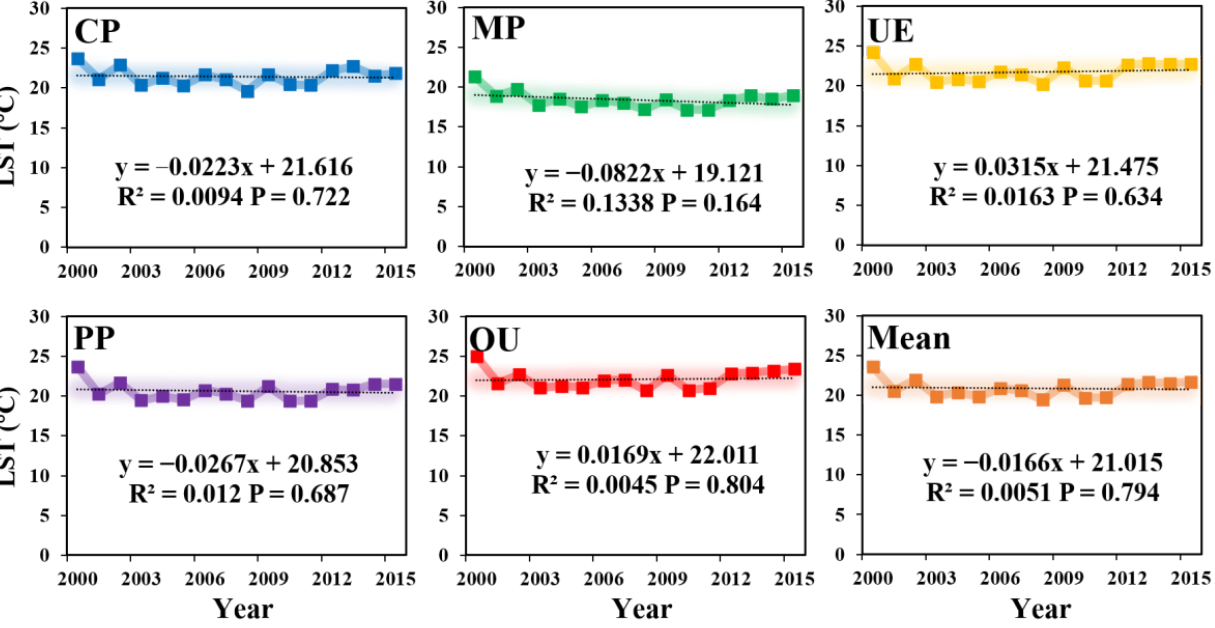
Figure 16. The trend in land surface temperature (LST) of different land use types in the Huang- Huai-Hai River Basin from 2000 to 2015.